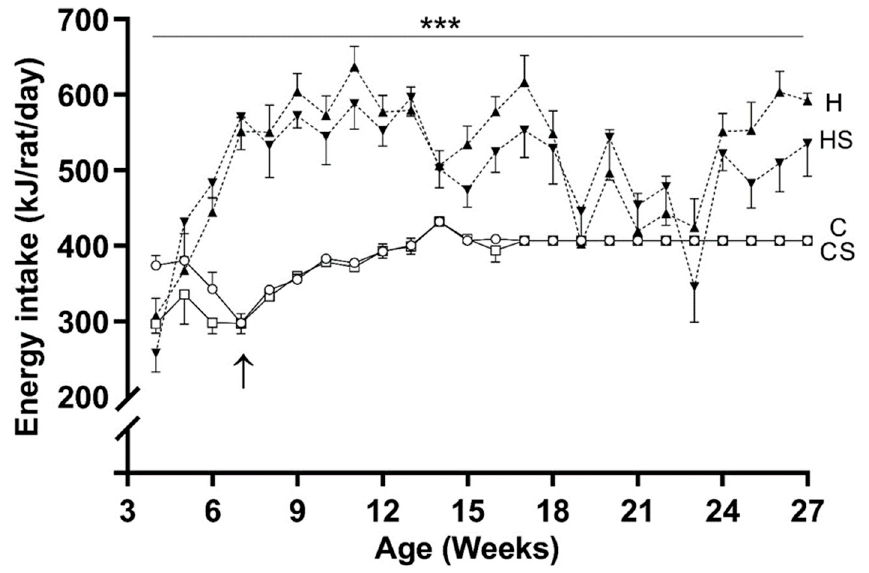
Figure 2. Energy intake from weaning until 27 weeks. Data are shown as mean ± SEM ( n = 17 per group) in rats consuming C (solid lines and open circle), CS (solid lines and rectangle), H (dotted lines and upright triangle) and HS (dotted lines and inverted triangle) diets. The arrow ( ↑ ) indicates start of pair-feeding in C and CS groups at 7 weeks of age. Abbreviations: C, Control diet; CS, Control diet with supplement; H, HFD; and HS, HFD with supplement. Effects of HFD and supplement were assessed by repeated measures two-way ANOVA followed by LSD post hoc. Overall HFD effect *** p < 0.001.